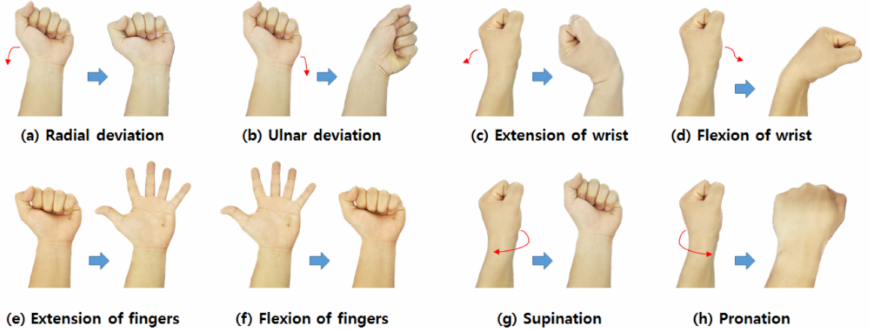
Figure 4. Eight motions of the wrist and fingers: ( a , b ) radial and ulnar deviation of the wrist; ( c , d ) extension and flexion of the wrist; ( e , f ) extension and flexion of fingers; ( g , h ) supination and pronation of the